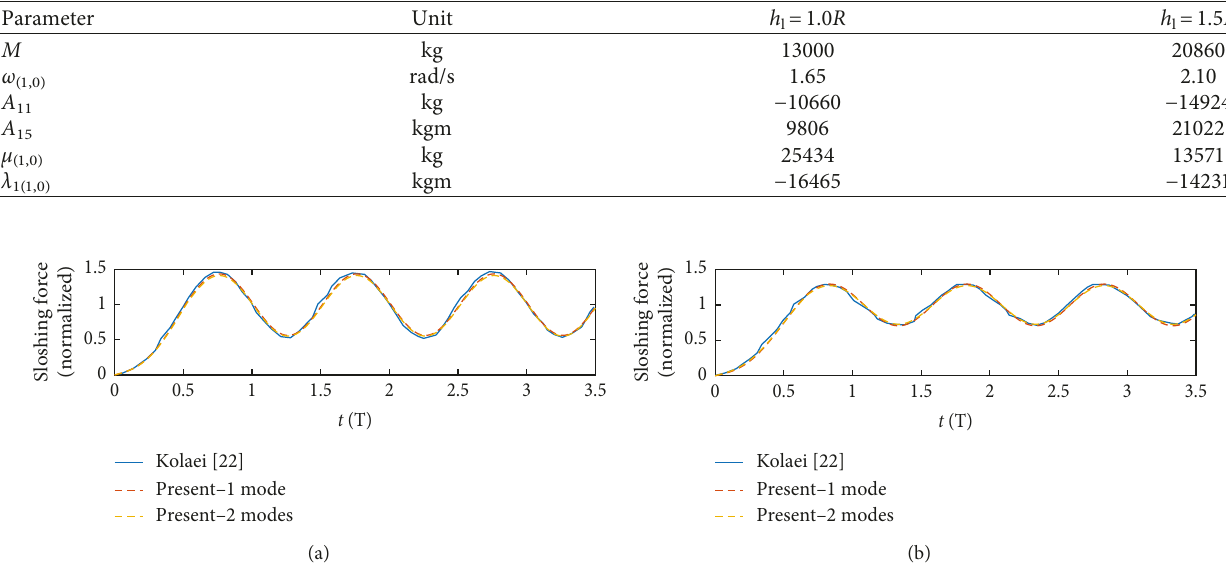
Figure 5: Added mass calculated by HydroSTAR: (a) A Table 2: Hydrodynamic coefficients calculated based on added mass.